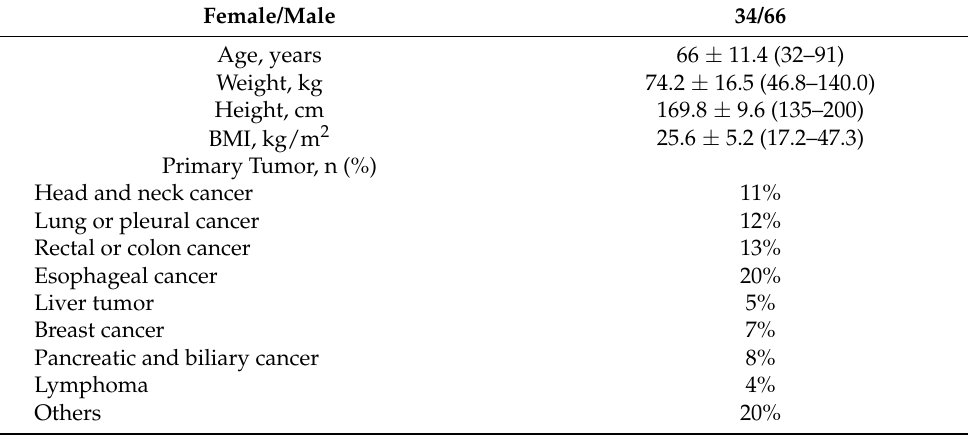
Figure 1. Flow chart of study. Table 1. Demographics of study patients ( n =